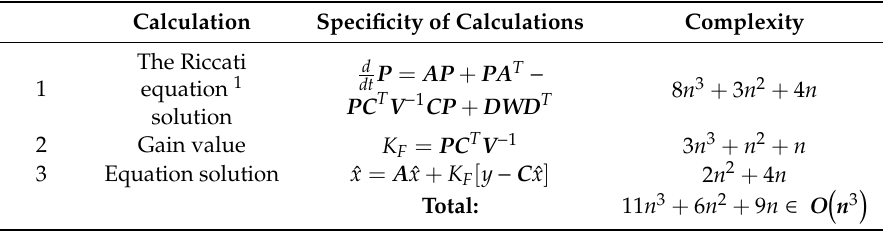
Table 2. Computational complexity of the Kalman filter